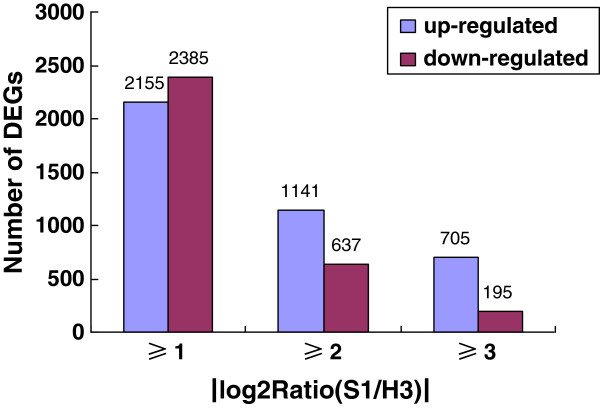
Comparison of expression of the mapped genes between S1 and H3. Columns denote the number of DEGs with an expression ratio within the stated range.